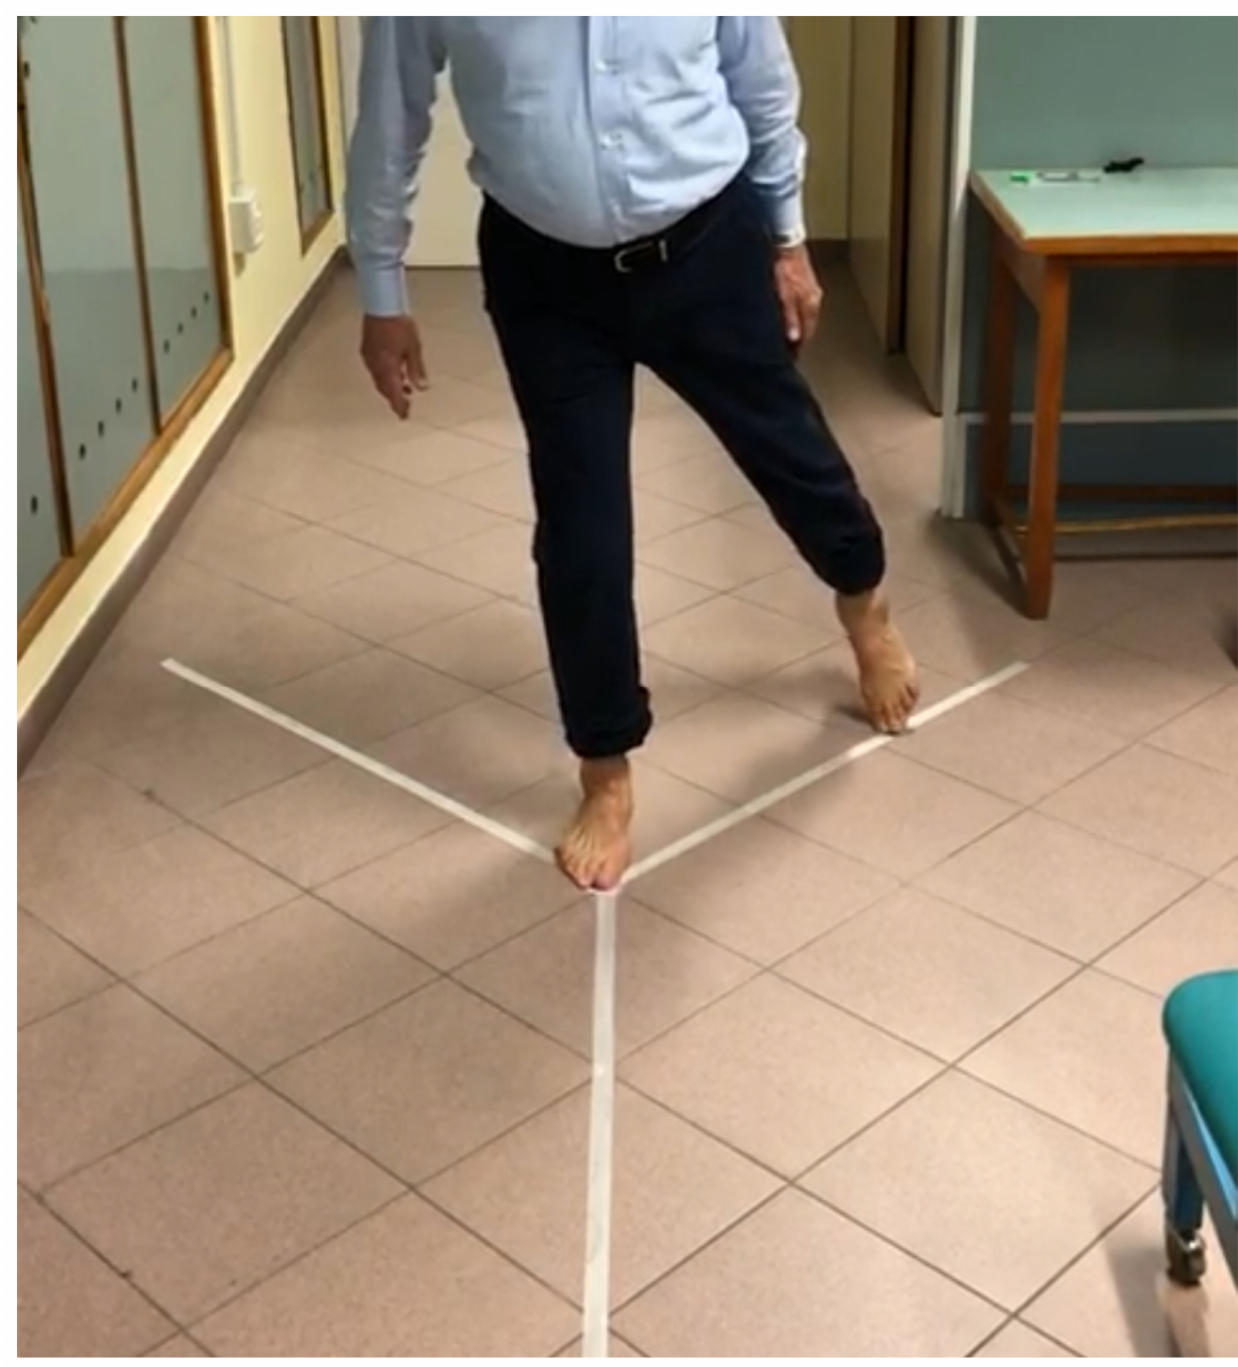
Figure 3. Y-Balance